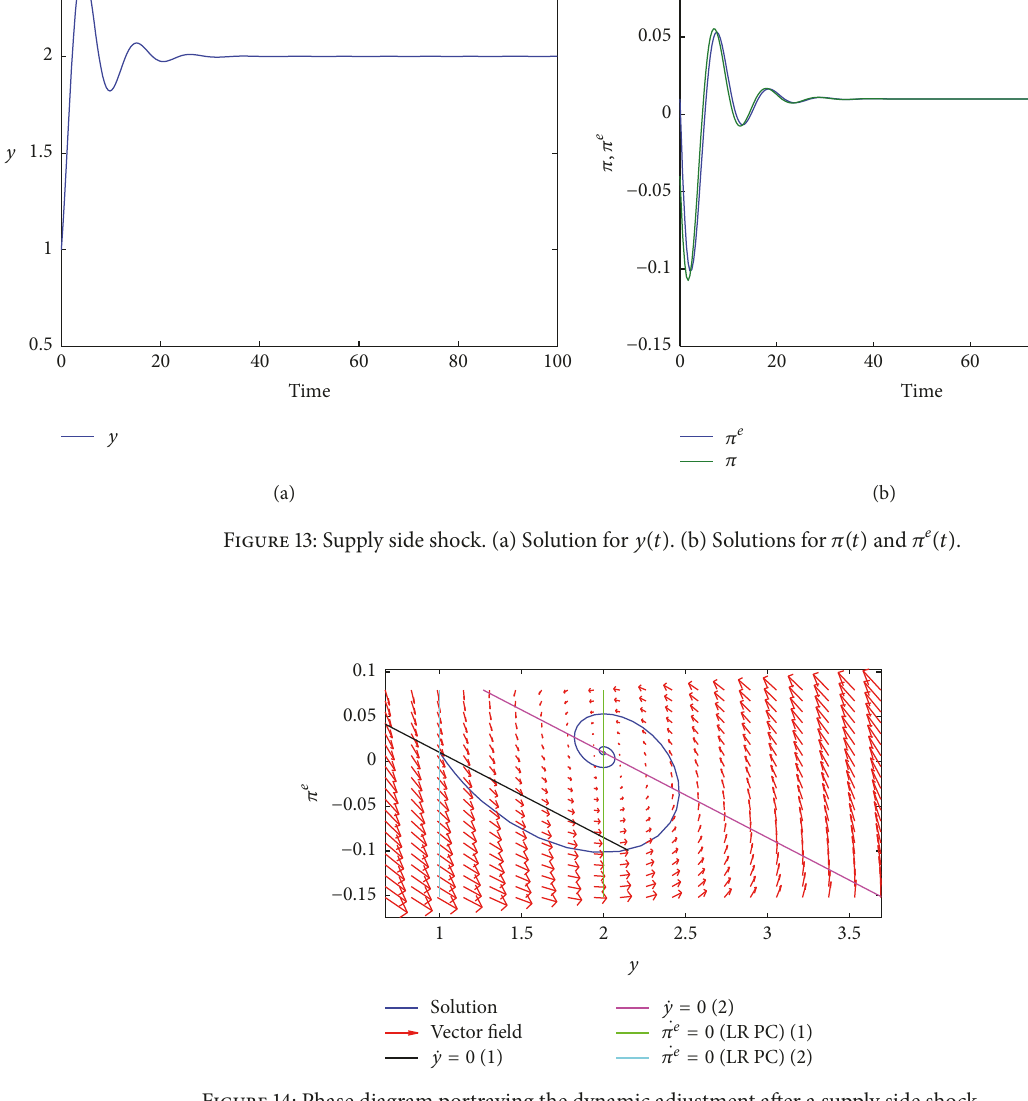
Figure 14: Phase diagram portraying the dynamic adjustment after a supply side